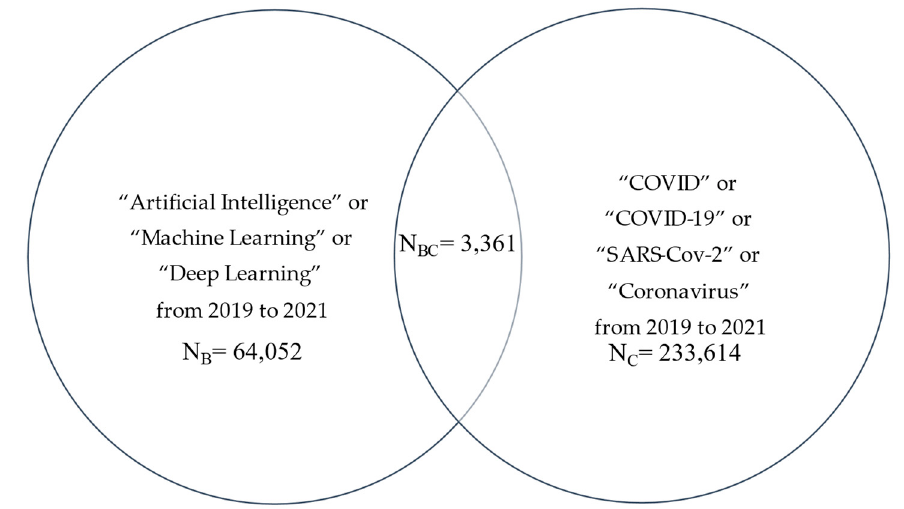
Figure 3. Number of literatures on AI/ML/DL and COVID-19 from 2019 to 2021.